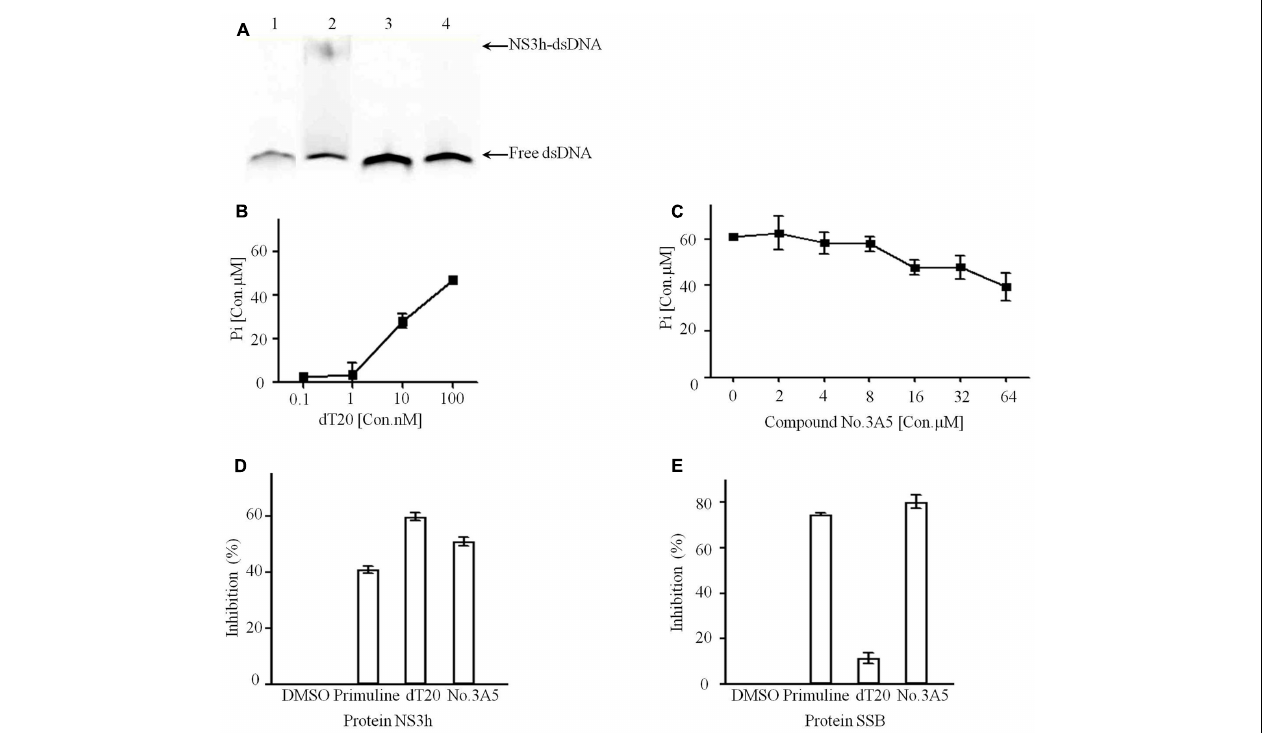
FIGURE 3 | Active compound No.3A5 disrupt the interaction between NS3h and nucleic acids. (A) EMSA. Samples were examined on a 15% native polyacrylamide gel. Lane 1, Cy5-dT20 only; lane 2, Cy5-dT20, NS3h and DMSO; lane 3, Cy5-dT20, NS3h and 50 µ M aurintricarboxylic acid; lane 4, Cy5-dT20, NS3h and 1 mM compound No.3A5. (B) In ATPase assays, addition of dT20 enhanced ATP hydrolyzation. (C) Increasing amount of compound No.3A5 could affect ATPase of NS3h. (D) Inhibition results showed compound No.3A5 had no binding selectivity on NS3h. (E) Inhibition results showed compound No.3A5 had no binding selectivity on SSB protein of Escherichia coli